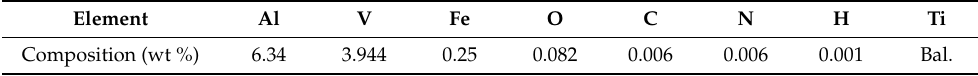
Table 1. Chemical composition of Ti6Al4V(ELI) alloy powder as determined in [26].